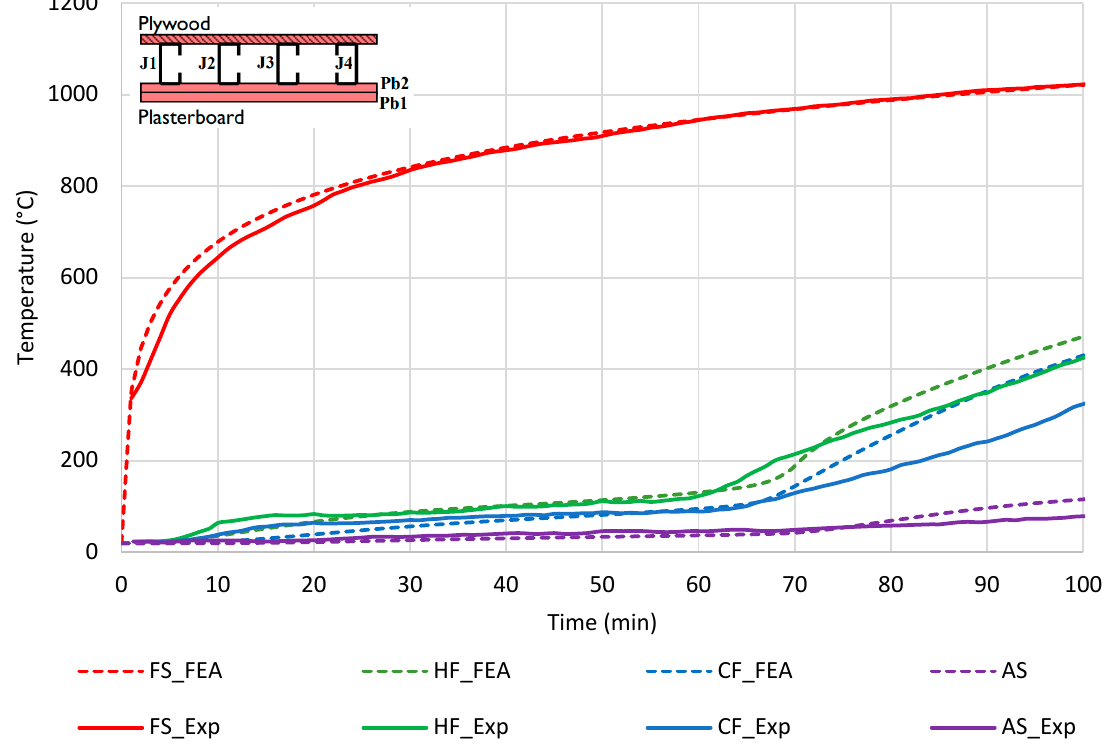
Figure 5. FEA versus experimental temperatures of floor panel specimen—Test 1 [1].